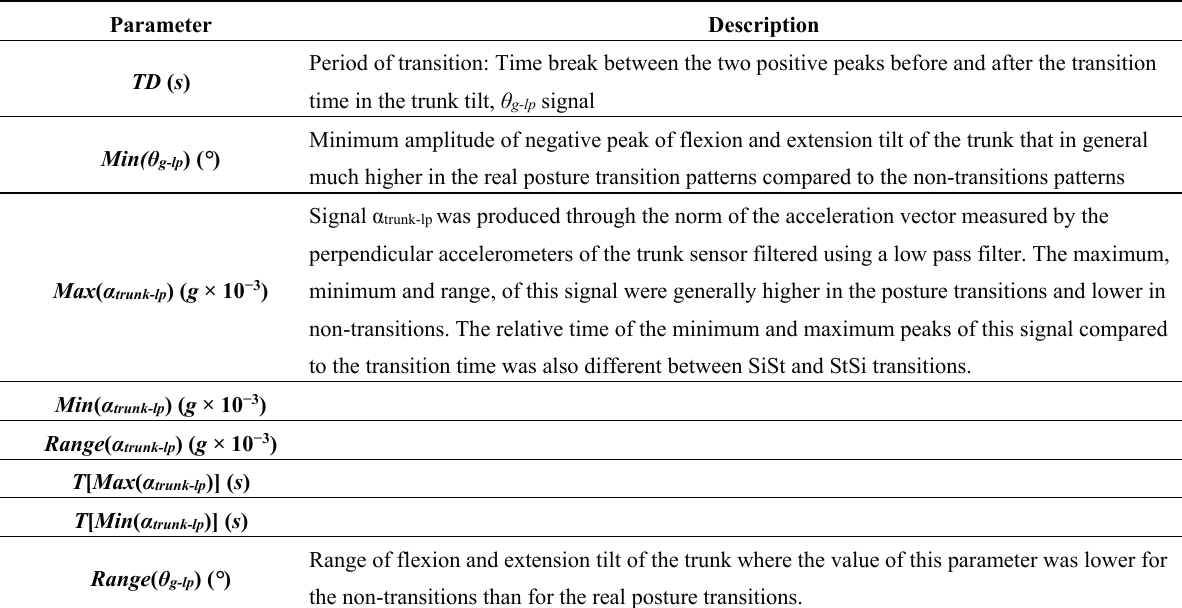
Table 2. List of posture transition related parameters